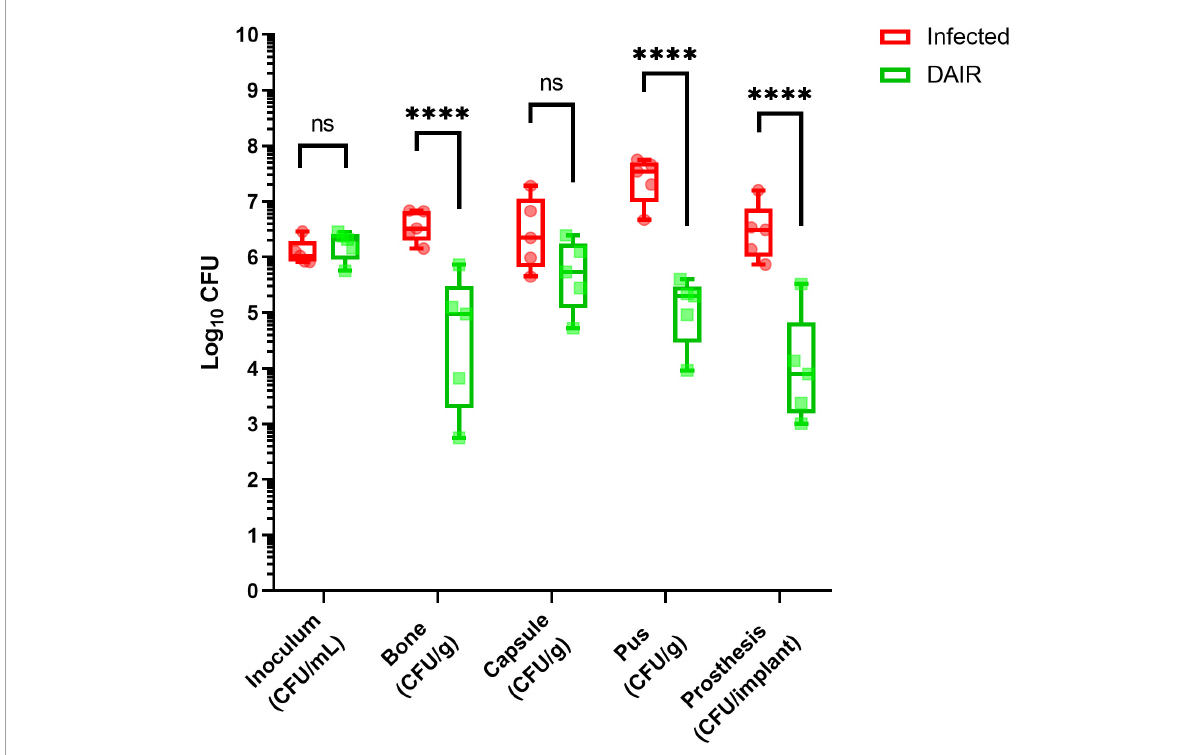
FIGURE4 Bacterial loads in the different samples for rabbits of groups B (red) and C (green), and multiple comparisons. Statistical analysis: two-way ANOVA and Tukey HSD. ns p > 0.05; ∗ p < 0.05; ∗∗ p < 0.01; ∗∗∗ p < 0.001; ∗∗∗∗ p < 0.0001. N =